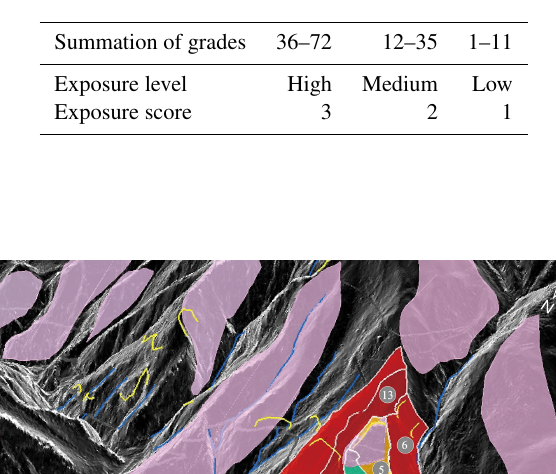
Table 10. Exposure level and score (Lin, 2017).